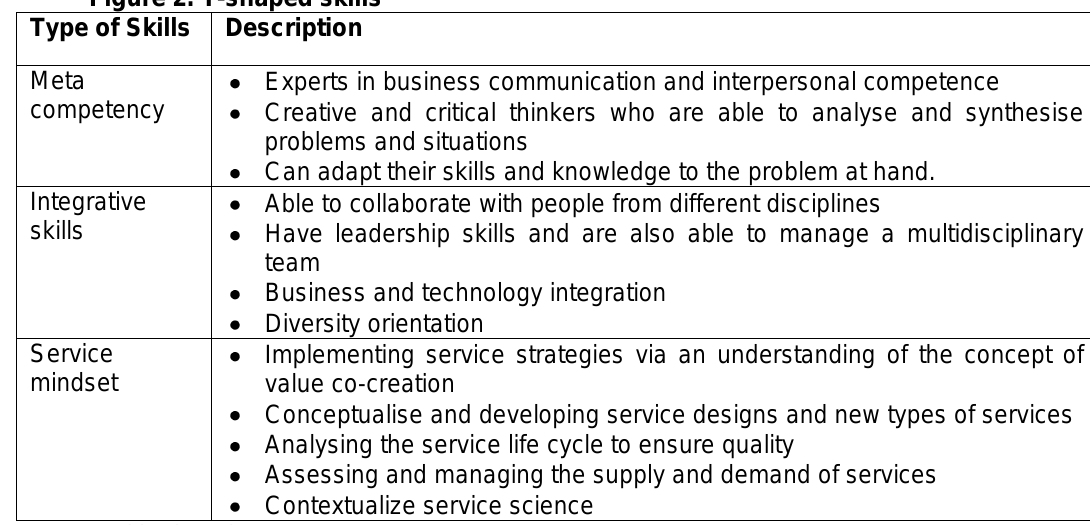
Figure 2: T-shaped